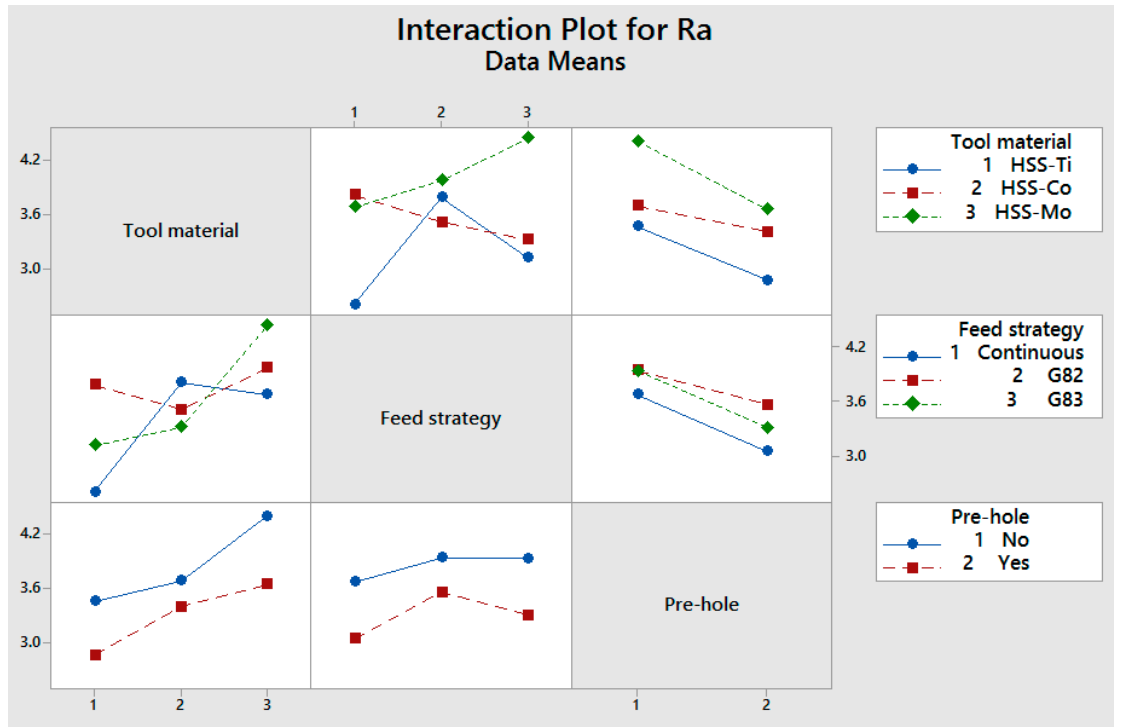
Figure 11. Interaction of cutting conditions versus surface roughness.